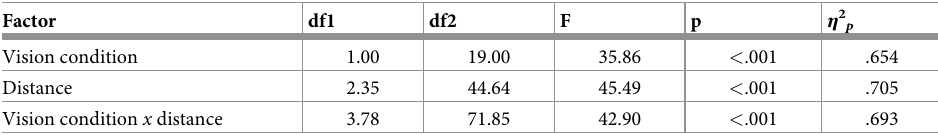
Table 7. Results of the two-factor ANOVA with repeated measures (6 distances; 2 vision conditions) for the con- stant error of the predicted putting distance. Corrected by Greenhouse-Geisser � . Factor